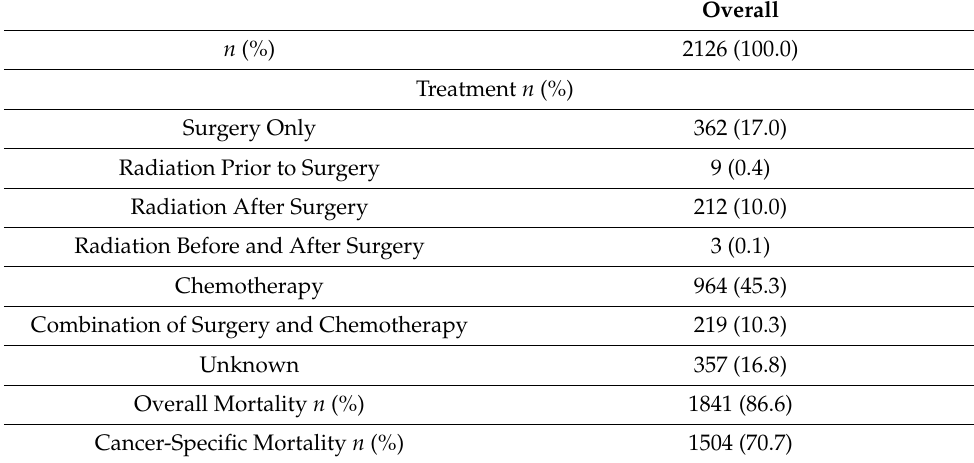
Table 4. Treatment Characteristics of 2126 Patients with Combined Small-Cell Lung Cancer from Surveillance Epidemiology and End Result (SEER) Database